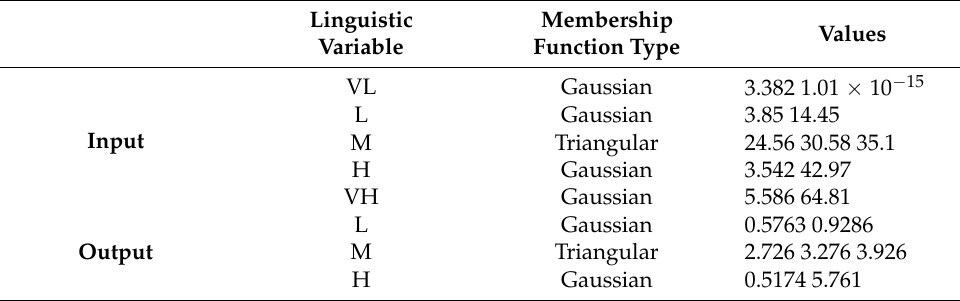
Table 3. Parameters of the type-1 membership functions.